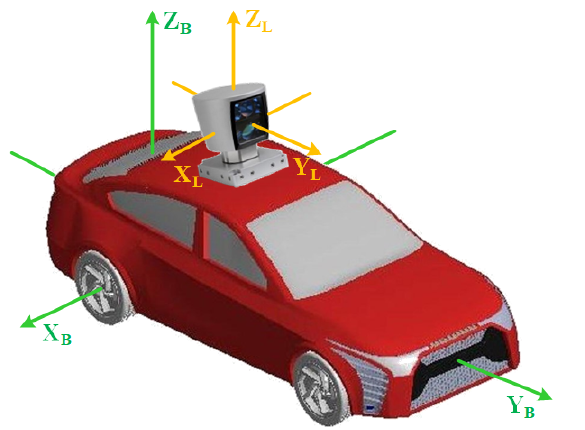
Figure 2. The relative relationship between the world coordinate system { W } and the body coordinate system { B } in the 2D plane, where the black axis indicates { W } and the red axis indicates { B } .